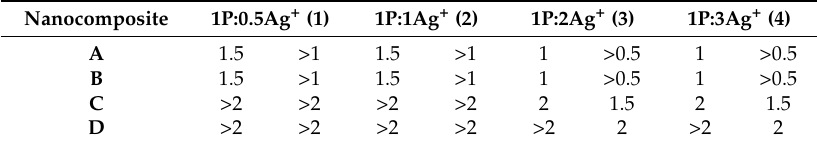
Table 7. MBC (left) and MIC (right) of the nanocomposites in mg/mL against E. coli .